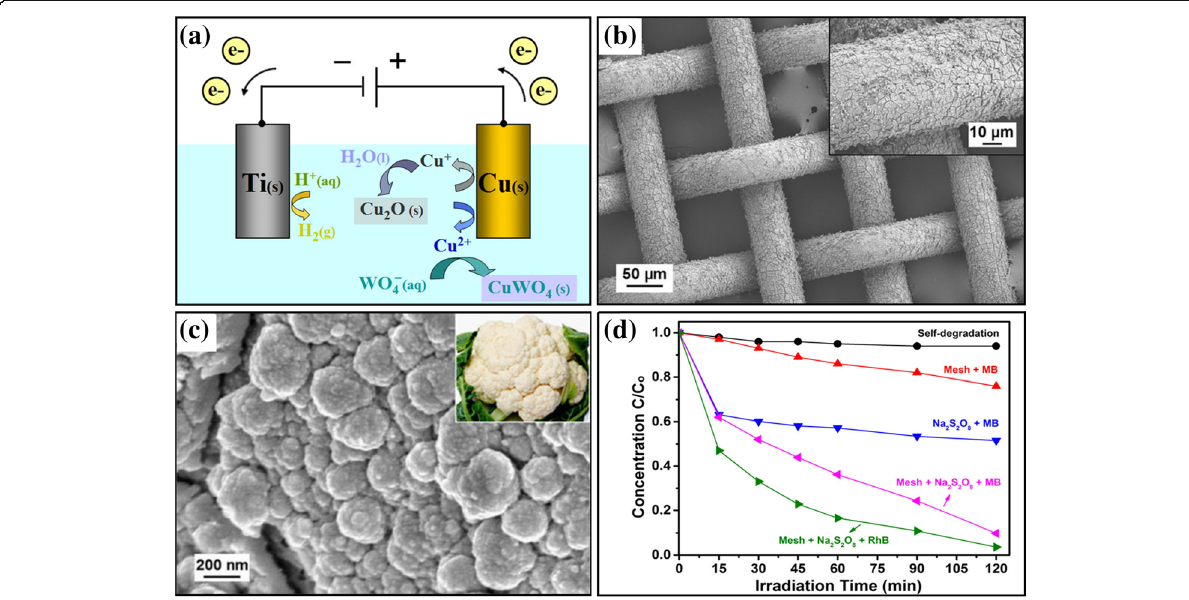
Fig. 7 a Schematic illustration of the growth of CuWO4@Cu2O on copper substrate by anodisation [68]. b , c Morphology and structure of the CuWO4@Cu2O film on copper mesh [68]. d Photodegradation curves of pollutants in water by using different photocatalysts under visible light irradiation